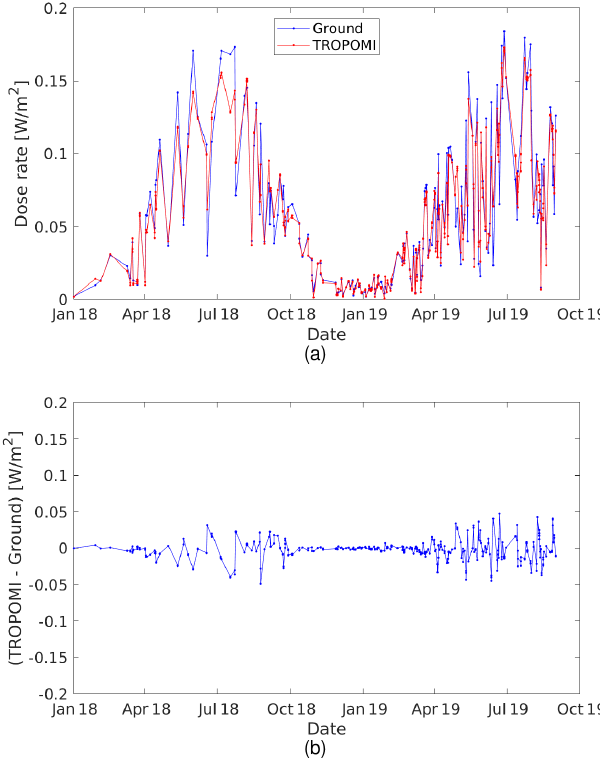
Figure 2. TROPOMI overpass and Brewer spectroradiometer (a) erythemal dose rates and (b) absolute difference of erythemal dose rates at Uccle, Belgium, during January 2018–August